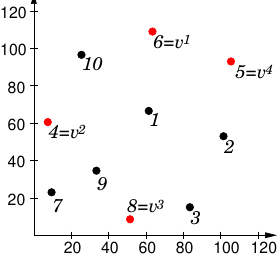
Figure 3. The four auxiliary points v 1 = 6, v 2 = 4, v 3 = 8, and v 4 = 5 determined for example instance